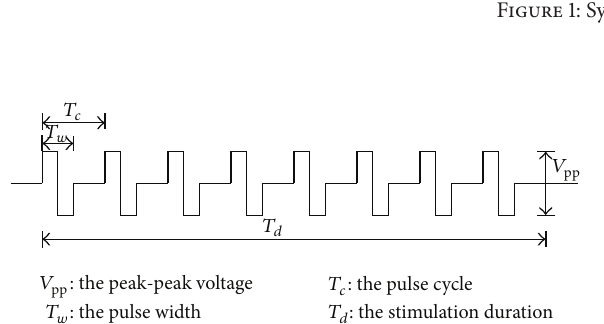
Figure 1: System principle.